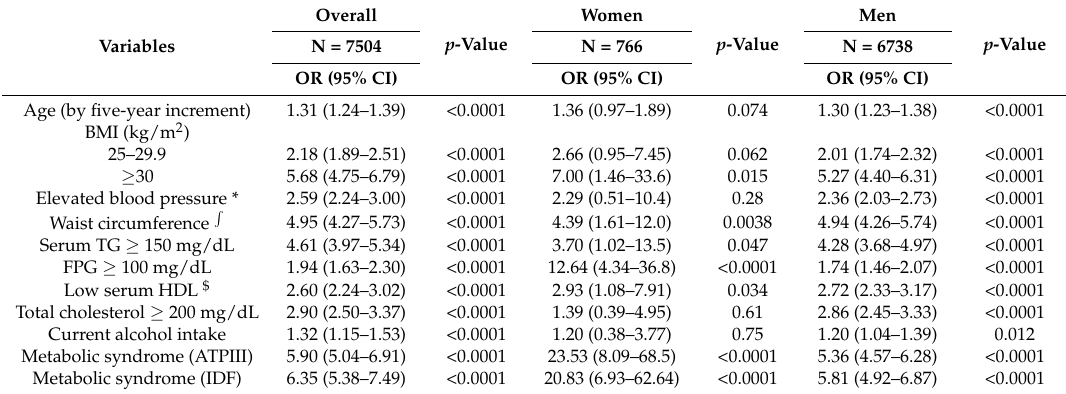
Table 3. Univariate analysis of risk factors predicting elevated ALT ≥ 40 U/L based on sex.